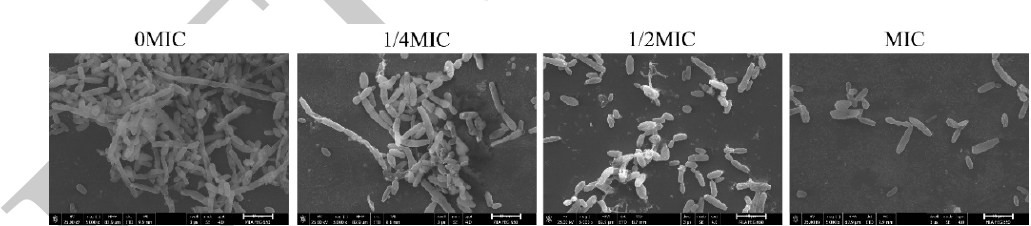
Figure 9. The effect of chelerythrine on the hyphal growth of C. albicans . Candida albicans cells were grown in an RPMI-1640 medium at the indicated concentration of chelerythrine at 37 °C for 24 h. Each field of vision was magnified 5000×. Scale bars represent 10 μ m.